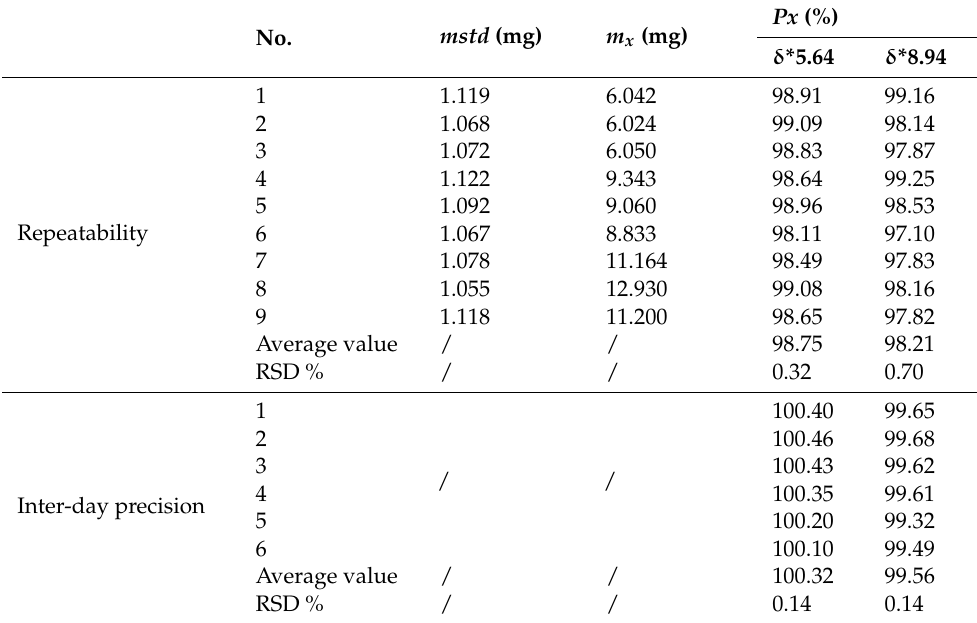
Table 2. Precision and repeatability results of Orlistat purity determination.